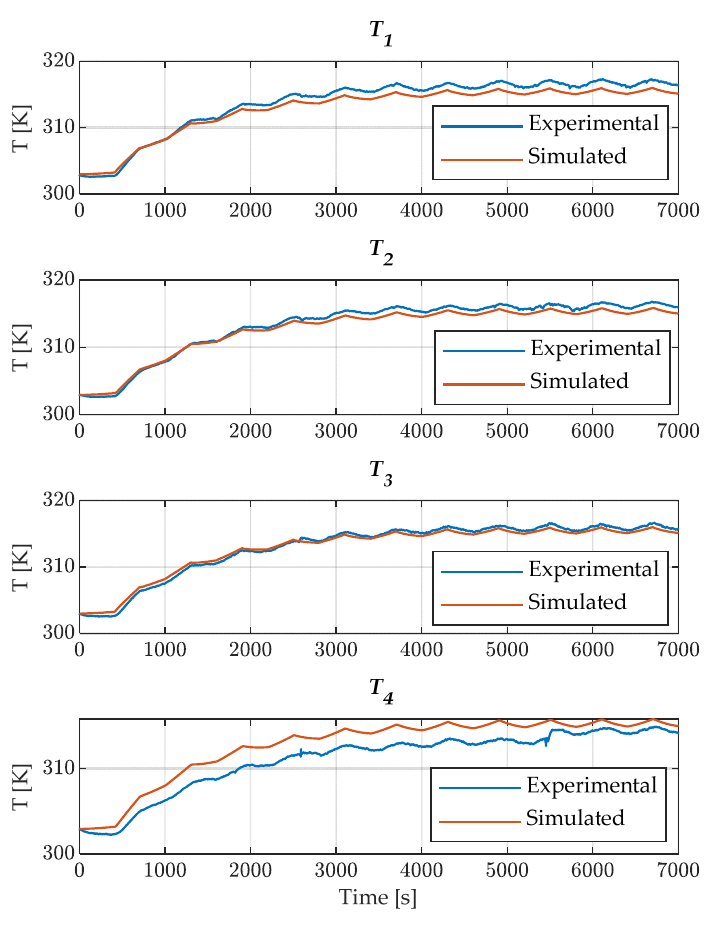
Figure 21. Thermocouples result for the three cells tests at 60 A.